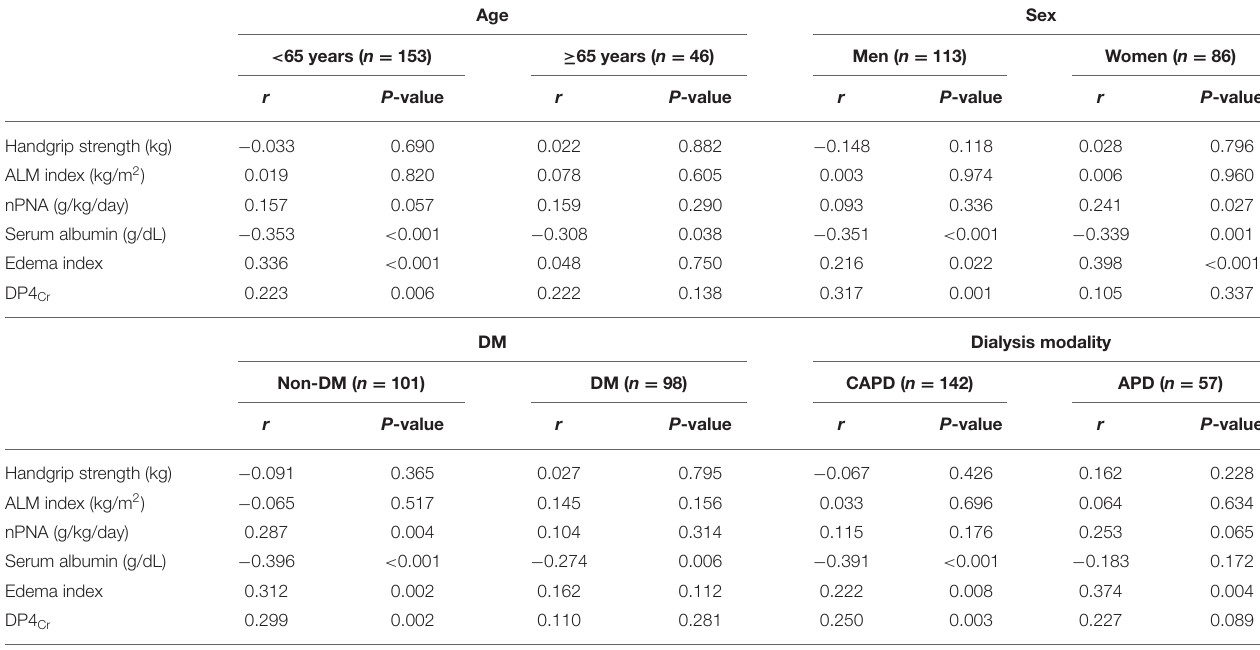
TABLE 2 | Correlation between peritoneal protein loss and various indices by